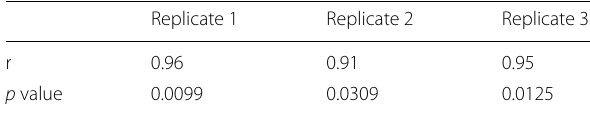
Table 1 The correlation of each replicate between abbreviated stem and detached leaf